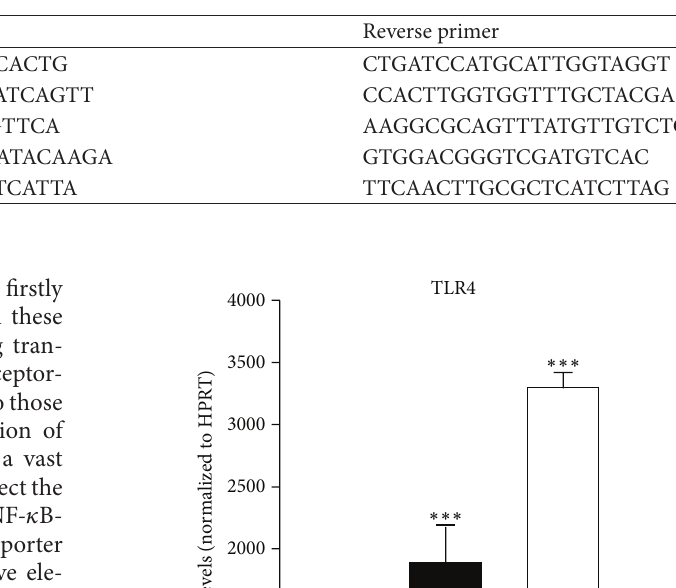
Table 1: Overview over primer sequences for RT-qPCR.